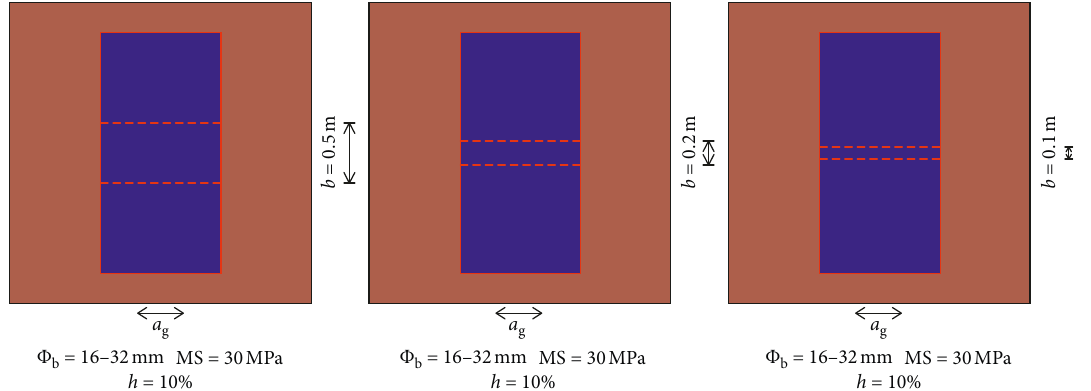
Figure 6: Analysed vertical contact stress below the foundation. (a) σ